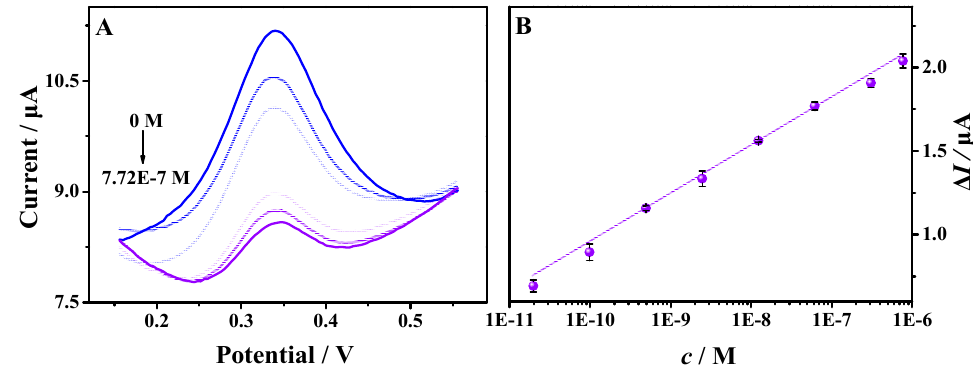
Figure 6. ( A ) DPVs of the biosensor for different concentrations of myoglobin: 0.00 M, 2.00 × 10 − 11 M, 1.00 × 10 − 10 M, 5.00 × 10 − 10 M, 2.50 × 10 − 9 M, 1.25 × 10 − 8 M, 6.18 × 10 − 8 M, 3.09 × 10 − 7 M, and 7.72 × 10 − 7 M